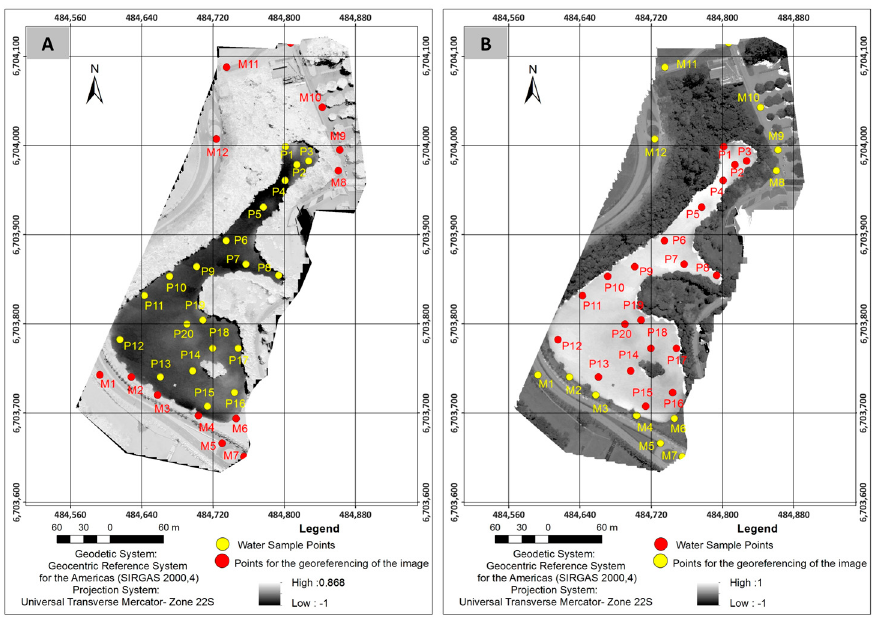
Figure 5. Images generated by the compositions of the spectral bands obtained by ANN: ( A ) NDVI image; and ( B ) NDWI image.